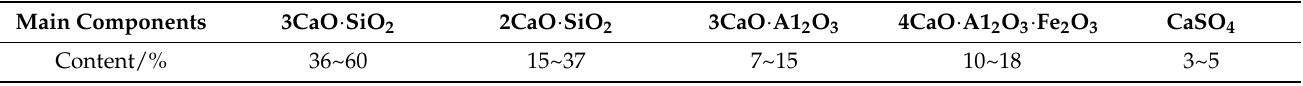
Table 1. Main components of ordinary Portland cement (P.O